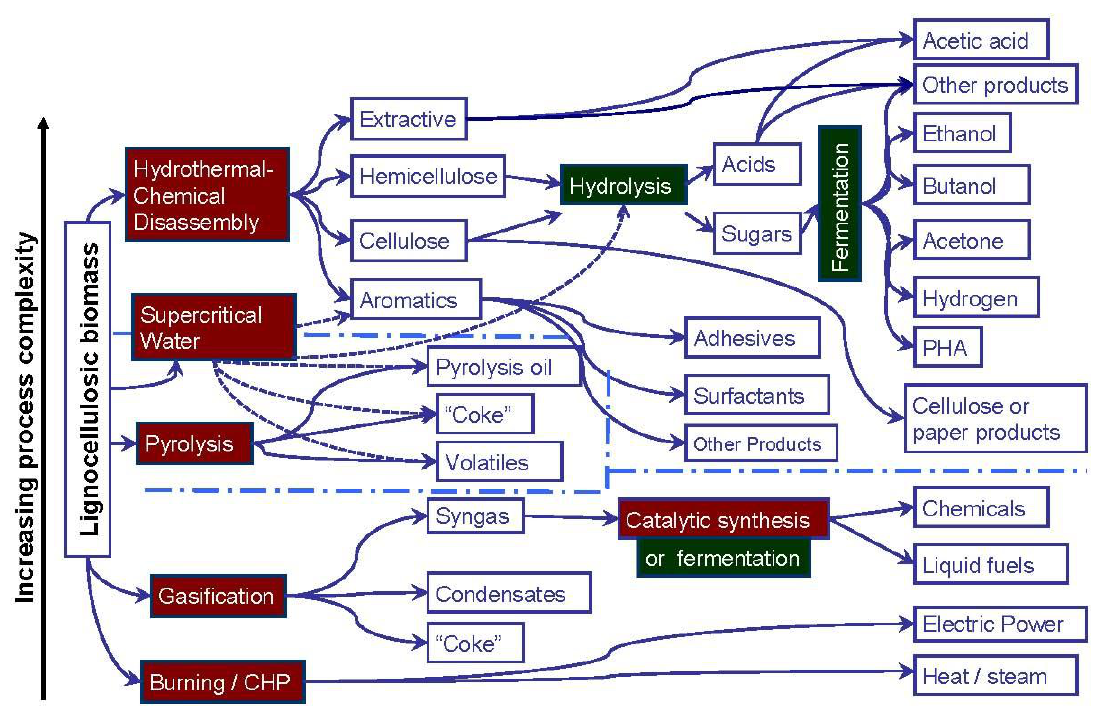
Figure 1. Generalized schematic of biorefinery processes (adapted from